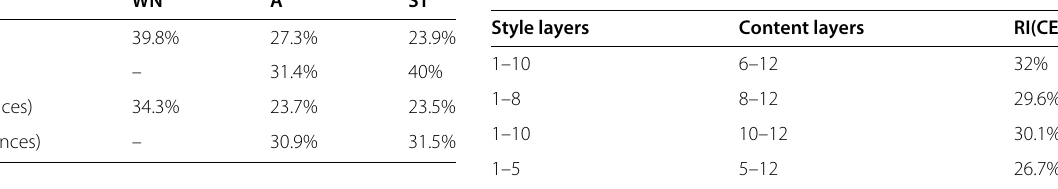
Table 8 Relative improvement depending on the content